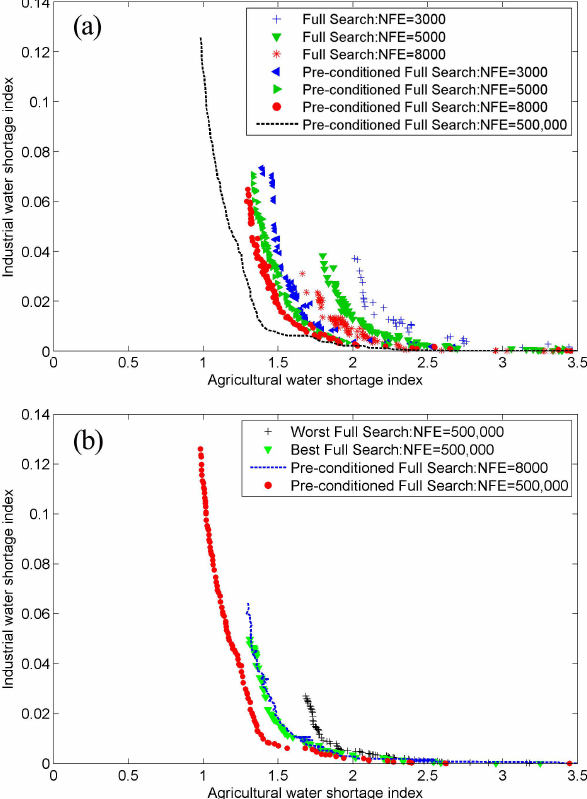
Figure 6. Pareto fronts derived from pre-conditioned and standard full searches for the Dahuofang ROS problem. (a) Sample Pareto fronts with different numbers of function evaluations for one ran- dom seed trial. (b) The best and worst Pareto fronts of 10 seed